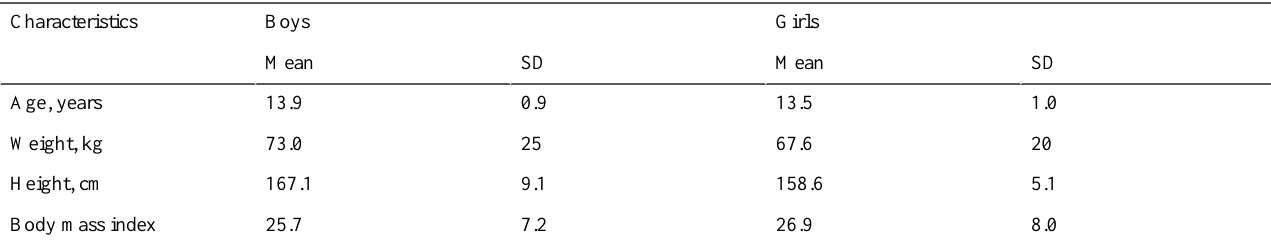
Table 2. Characteristics of adolescents using the mobile phone food record (mFR) while attending a summer camp.